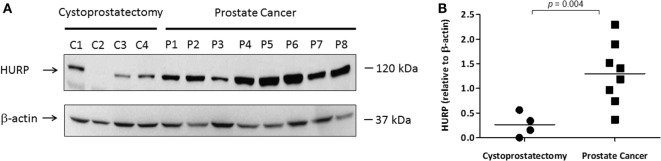
Expression of HURP protein in PCa tissues. Protein lysates (50 μg) extracted from frozen prostate tissues (C1–C4 samples from cytoprostatectomy patients and P1–P8 samples from PCa patients) were separated by SDS-PAGE. (A) Hepatoma upregulated protein (HURP) and beta (β)-actin levels in the samples were identified by Western blot as described in Section “Materials and Methods.” (B) The results were normalized to β-actin. Normalized ratios were compared between controls and PCa tumors. The level of significance was set at p < 0.05 between PCa and cytoprostatectomy samples.